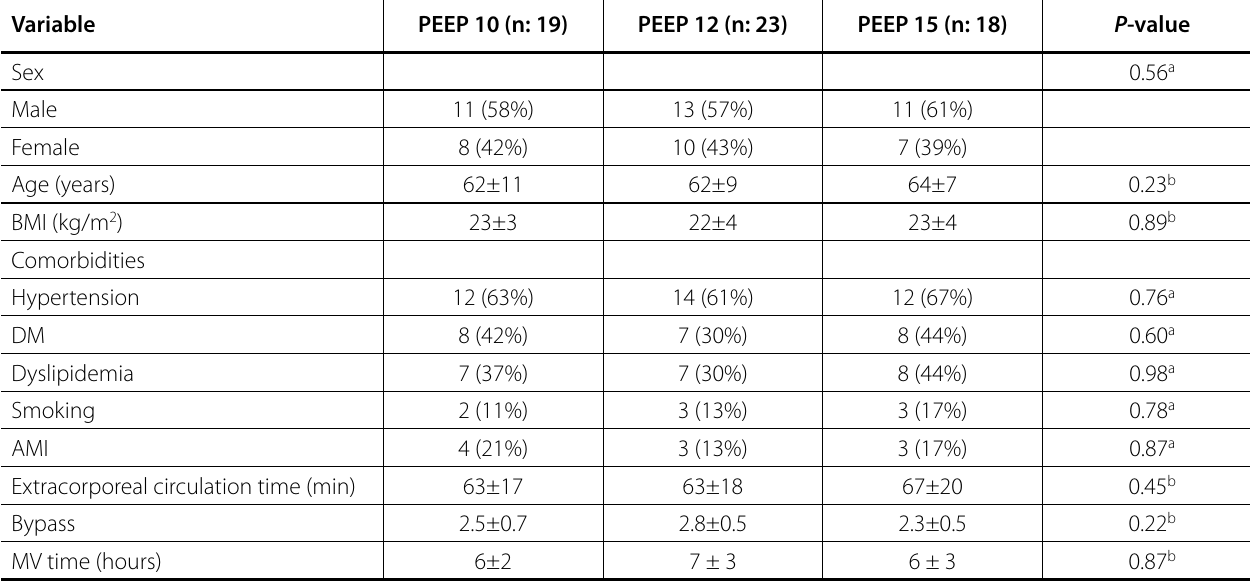
Table 1 . Clinical and surgical characteristics in different levels of PEEP of patients submitted to CABG. Variable